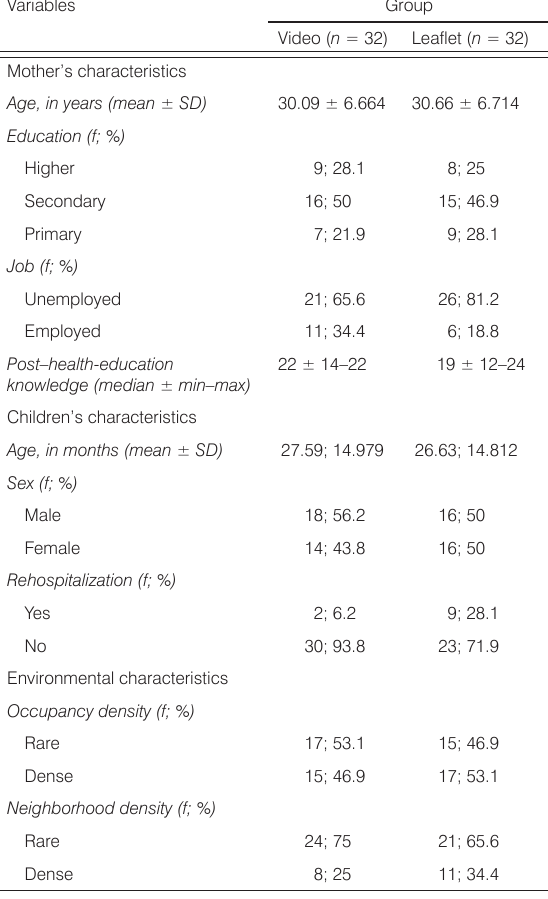
Table 1. The distribution of respondents according to mother, children, and environmental characteristics.